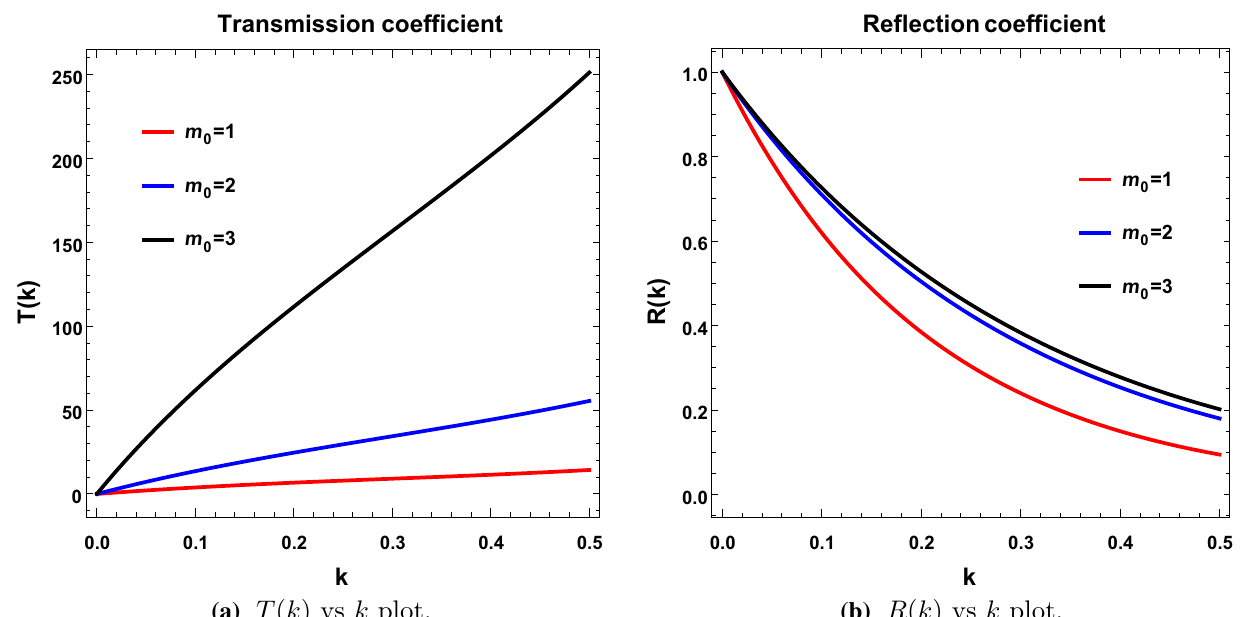
(b) R ( k ) vs k plot.